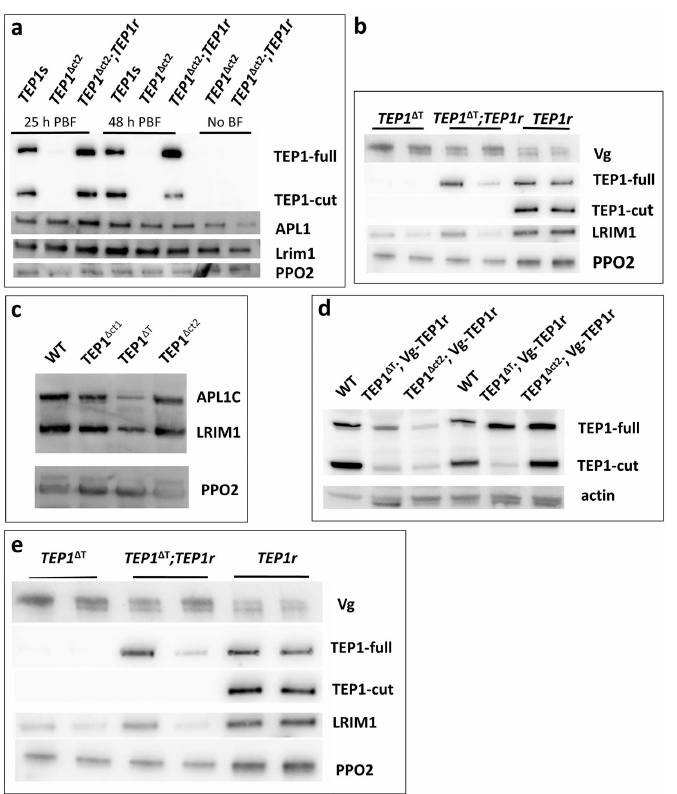
Fig 3. Transgenic expressionof TEP1r under the Vg promoter. a . Western blot analysisof hemolymph from Plasmodium infected wild type ( TEP1s ), mutant ( TEP1 Δ ct2 ) and mutant mosquitoesectopically expressing TEP1r ( TEP1 Δ ct2 ;TEP1r; ) showingfull (TEP1-full) and cleaved(TEP1-cut) TEP1 forms, LRIM1 and APL1C protein, 25 and 48h after infectiousbloodfeeding. PPO2 is used as a loadingcontrol b . Western blot analysisof hemolymphfrom Plasmodium infected mosquitoes of the TEP1 Δ T mutant background ( TEP1 Δ T ), ectopicallyexpressing TEP1r ( TEP1 Δ T ; TEP1r ) and wild type L3-5 mosquitoesexpressingonly